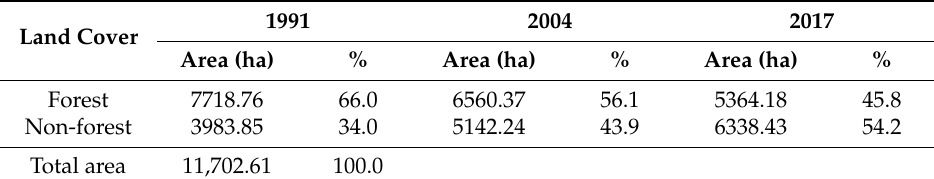
Figure 2. Forest cover maps of Mwazisi in ( a ) 1991; ( b ) 2004; and ( c ) 2017. Table 1. Change in forest cover from 1991 to 2017.